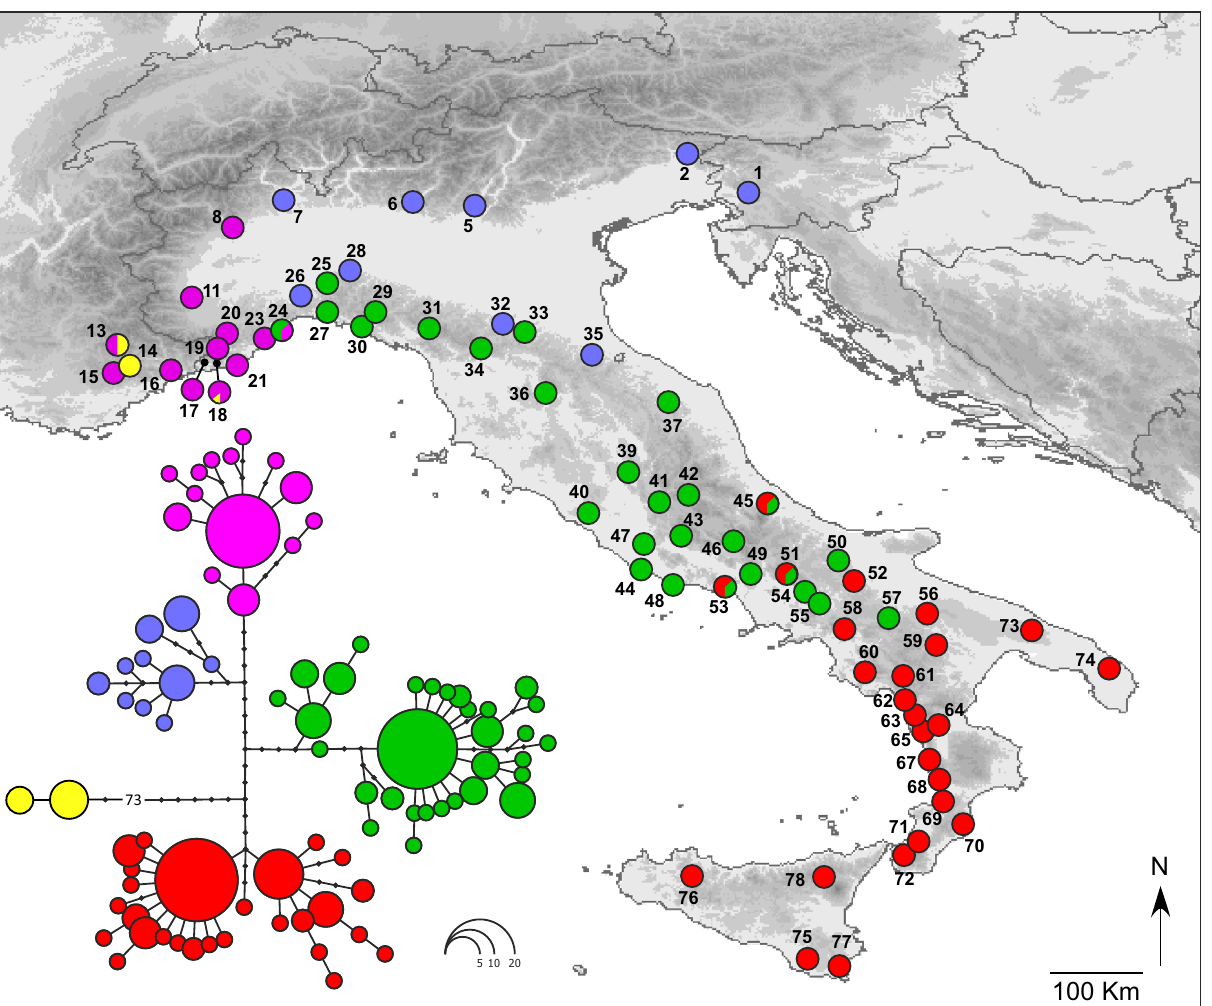
Figure 1. Maximum likelihood phylogenetic network of the Bufo bufo mitochondrial haplotypes found in Italy, and geographic distribution of the main haplotype groups. Circle sizes are proportional to haplotype frequency, and black dots represents missing intermediate haplotypes. Populations are numbered as in Table 1. The map was drawn using the software Canvas 11 (ACD Systems of America,